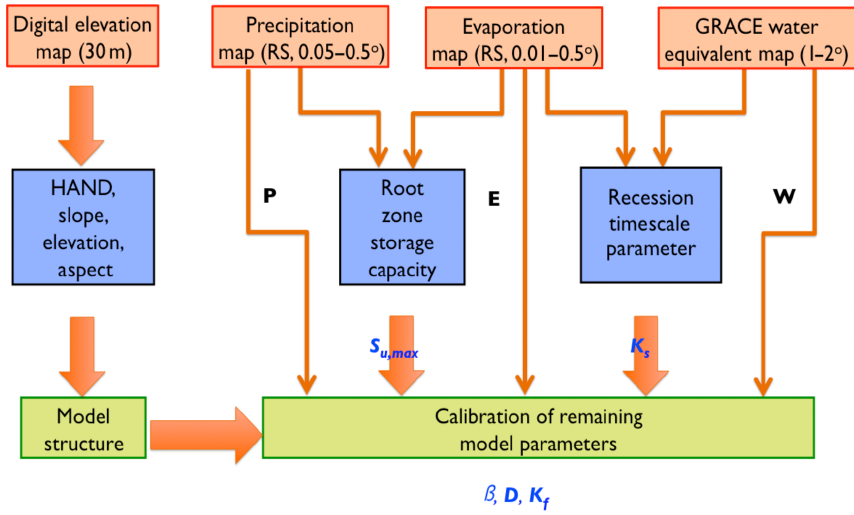
Figure 6. Readily available remote sensing products can be used to constrain hydrological models in a way that allows streamflow prediction in ungauged basins. The above schematic shows the relevant connections to consider during a calibration procedure. HAND refers to the height above the nearest drainage (which is the hydraulic head); root zone storage capacity is the maximum amount of soil water that can be accessed by the vegetation root systems; the recession timescale parameter controls the steepness of the recession. P , E , and W represent precipitation, evaporation, and soil water content, with RS indicating a remotely sensed source. S u, max is the root zone storage capacity, K s is the slow recession timescale, and β , D , and K f are the exponent of the threshold function for runoff generation, the splitter between recharge and runoff, and the fast recession timescale, respectively. Note that the root zone storage capacity of ecosystems reflects in part the ability of vegetation to distribute its roots to optimize soil water usage. Through the calibration scheme shown above, we can use historical time series of precipitation and evaporation to derive the effective storage capacity utilized by the ecosystem and then connect it to the ecosystem’s survival strategy (Gao et al., 2014). In addition, through such an approach, we can investigate how ecosystems will adjust their storage capacity in response to climatic change and how rainfall–runoff relations will change as a result. (Contact: Hubert Savenije. See Savenije and Hrachowitz (2017) for more